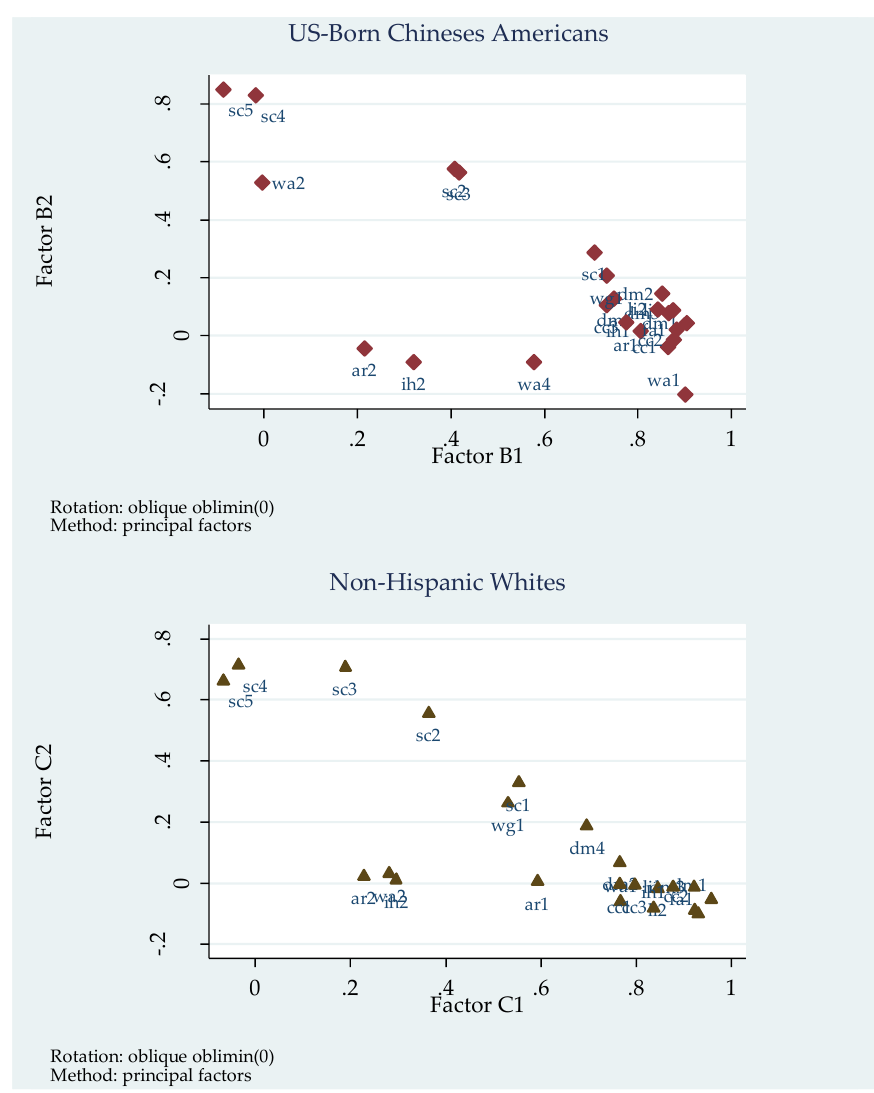
Figure 1. Factor Loading Plot.